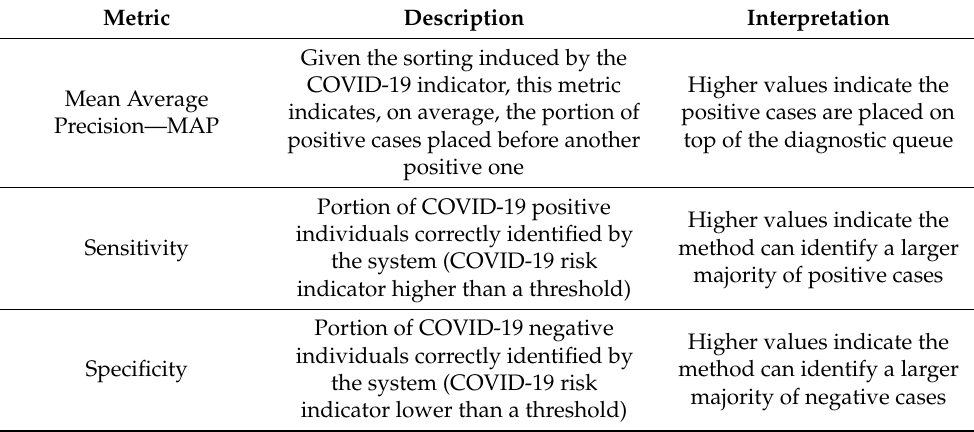
Figure 3. Data selection and labelling during phase 1. Images have been assigned to different groups according to RT-PCR test (for COVID-19) and assessment by a team of radiologists (for other diseases). Table 1. Metrics estimated for performance